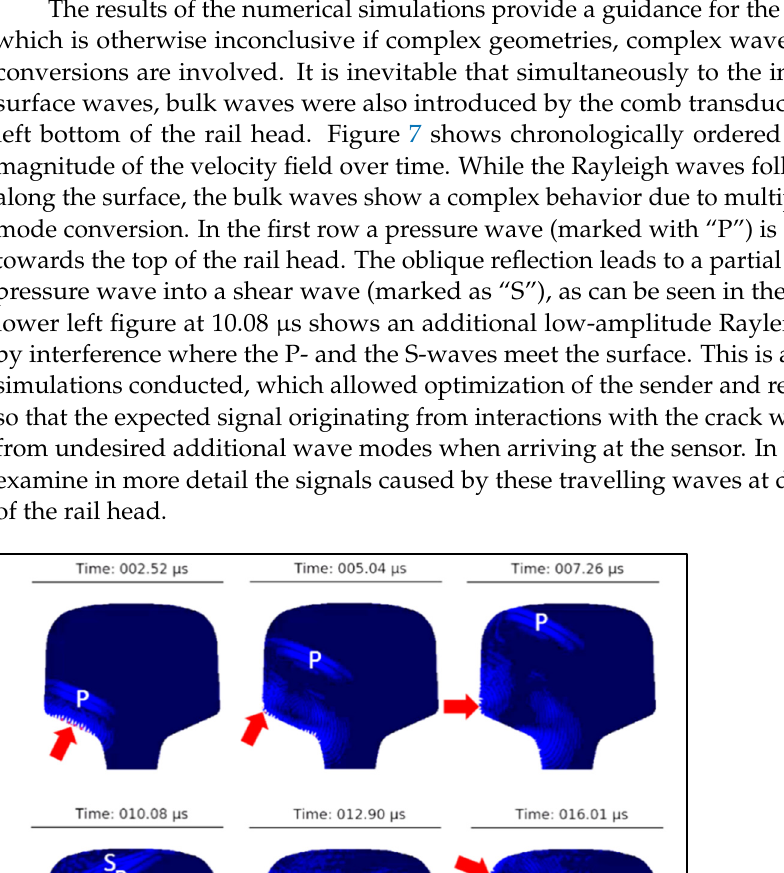
Figure 6. Three different crack geometries as modelled in the simulations. The rail cross-section corresponds to the standard 60E1 (UIC60) profile (EN 13674–1).